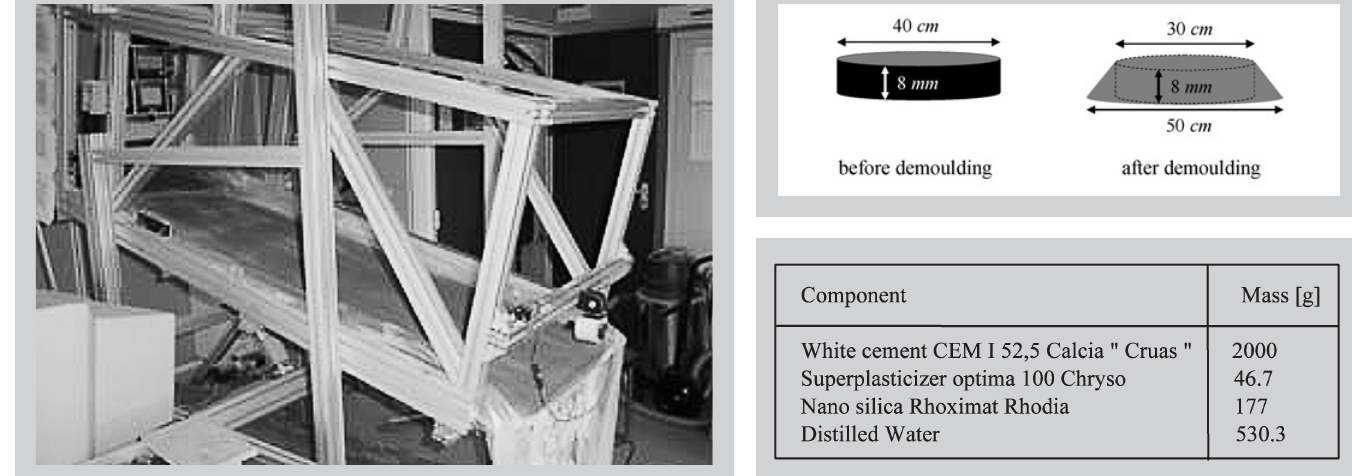
Figure 2 (left): Instrumented inclined plane used for dynamic tests. Figure 3 (right): Schematic representation of the removal from the mould. Table 1: Cement paste